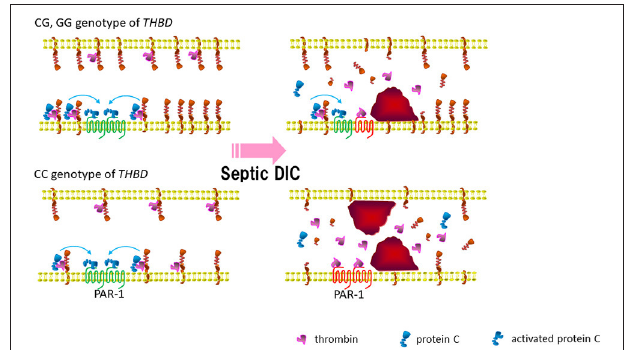
FIGURE 3 | Thrombomodulin gene promotor may influence thrombomodulin guided activated protein C (APC) function and limit endothelial cell damage in sepsis. In the blood stream, the thrombomodulin levels influence APC and antiinflammatory PAR-1 signaling. Bottom right: restricted thrombomodulin (due to carriage of CC genotype of rs2239562) promote thrombin induced inflammation and endothelial cell damage. APC, activated protein C; PAR-1, protease-activated receptor-1; DIC, disseminated intravascular